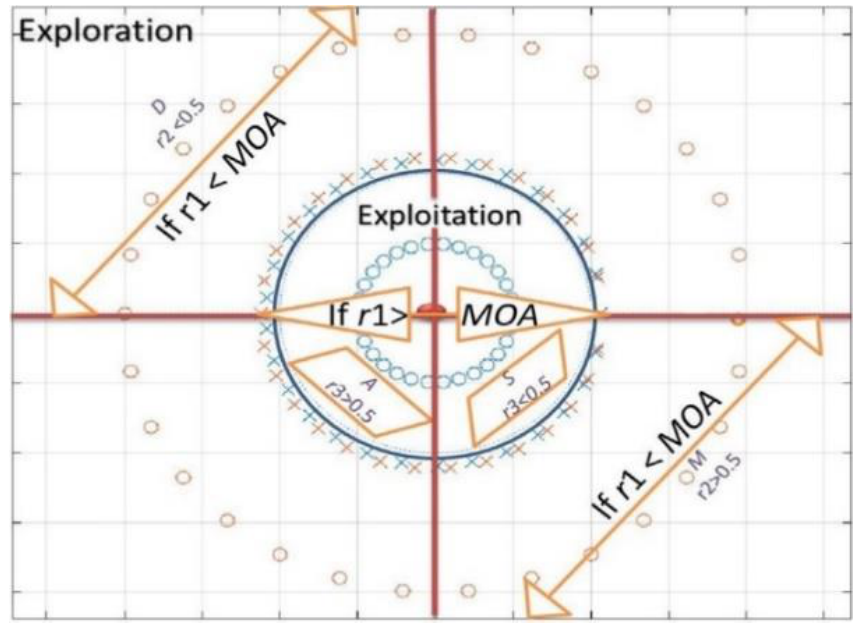
Figure 2. The different search phases of